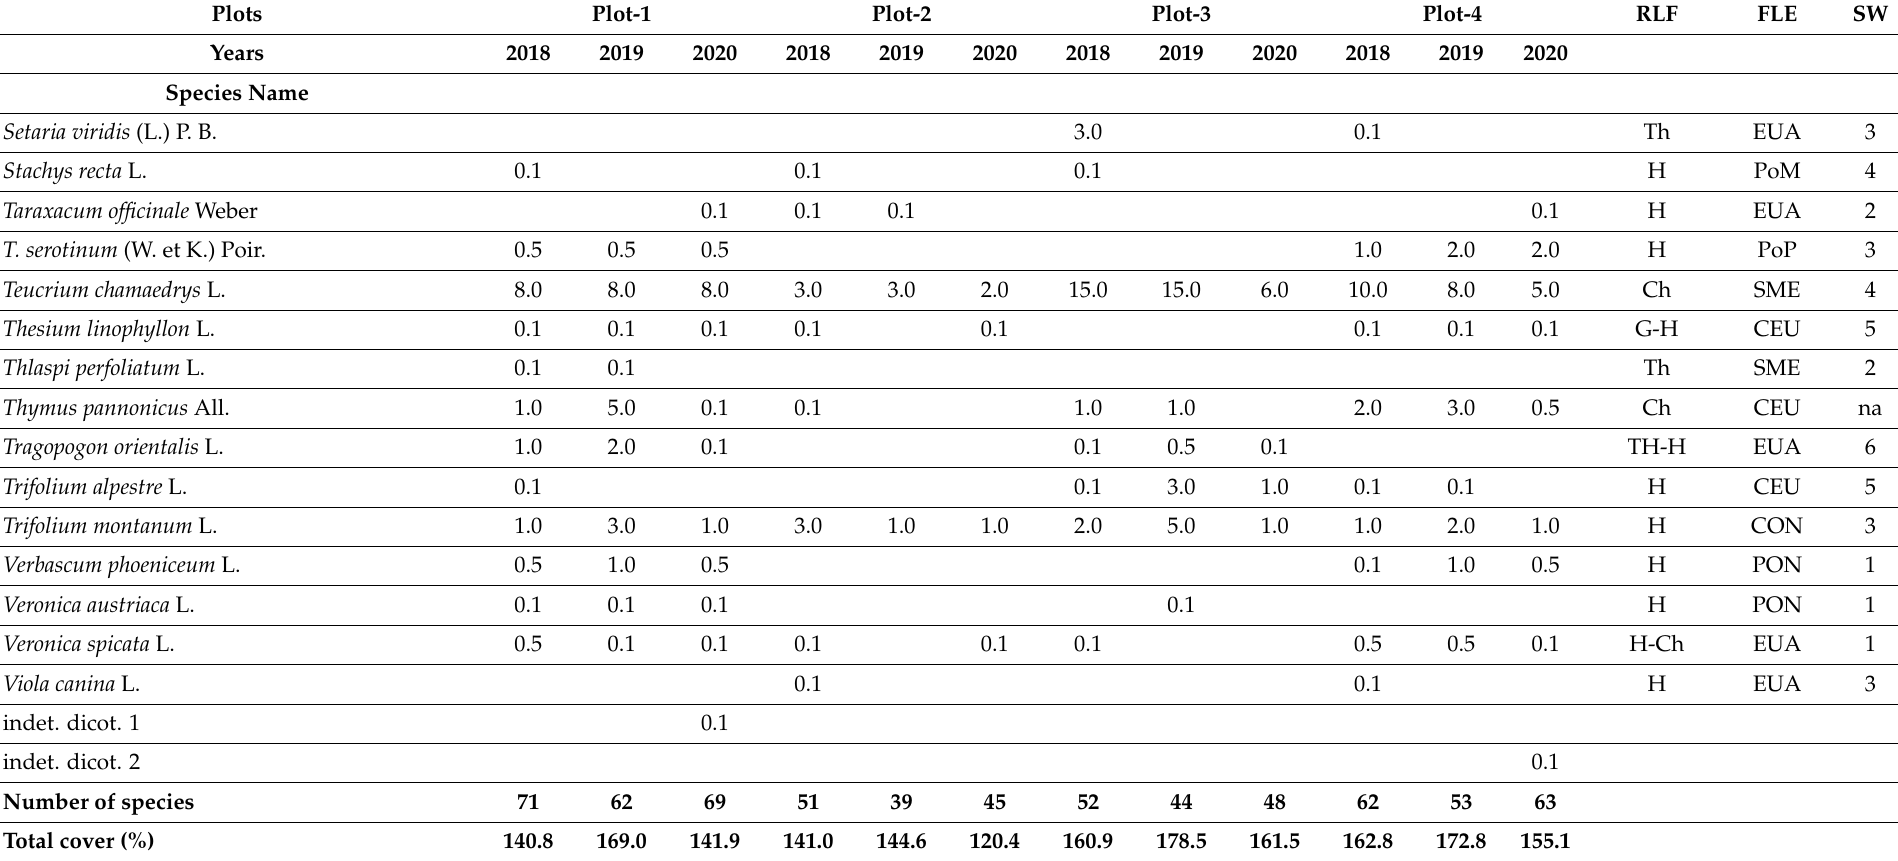
Table A1. Cont. Plots Plot-1 Plot-2 Plot-3 Plot-4 RLF FLE